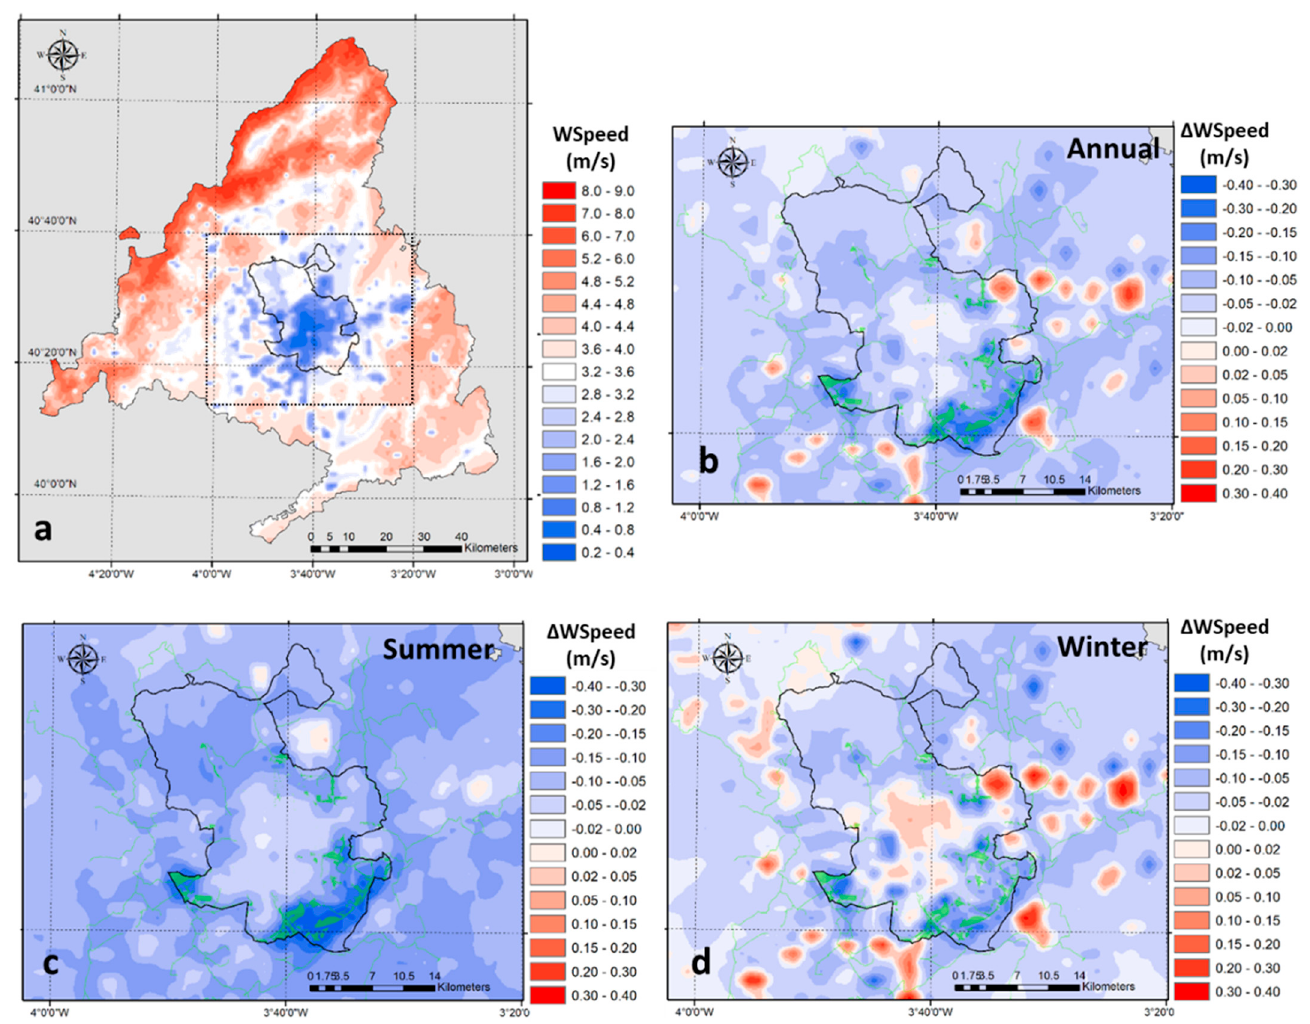
Figure 5. Annual mean wind speed (10 m) for the Baseline Scenario ( a ). Expected variation in wind intensity: annual mean ( b ), summer mean ( c ) and winter mean ( d ), due to future